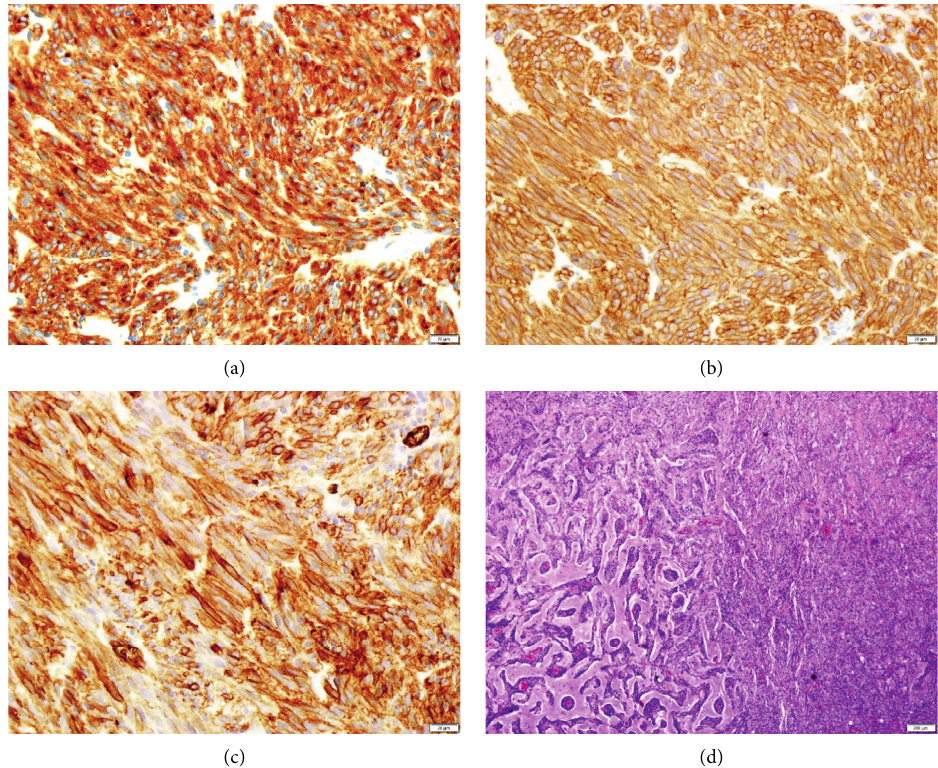
Figure 4: Spindle cell neoplasm with an immunohistochemical study showing positivity for CD117 (a), DOG1 (b), and CD34